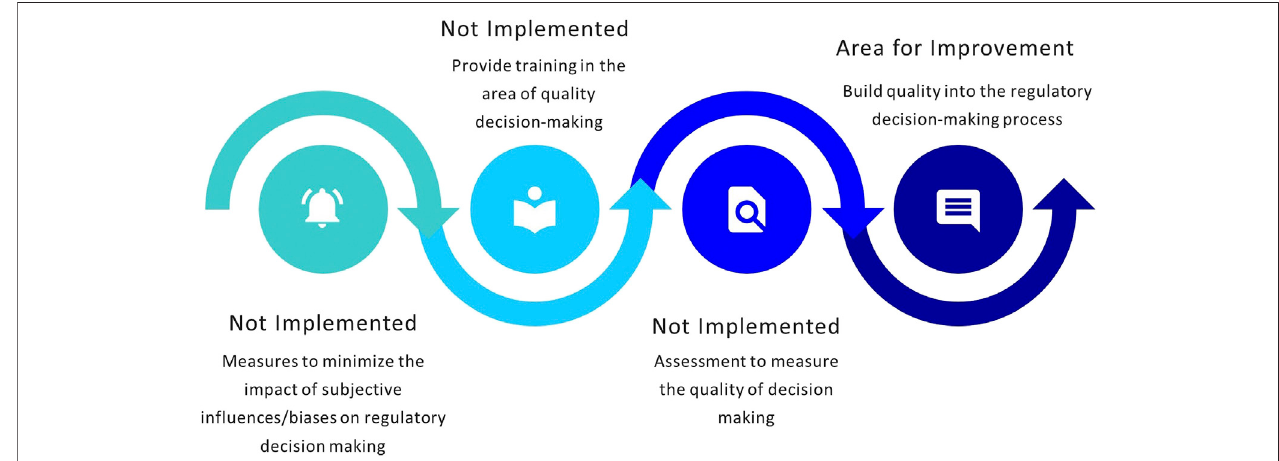
FIGURE 4 | Status of implementation of quality decision-making